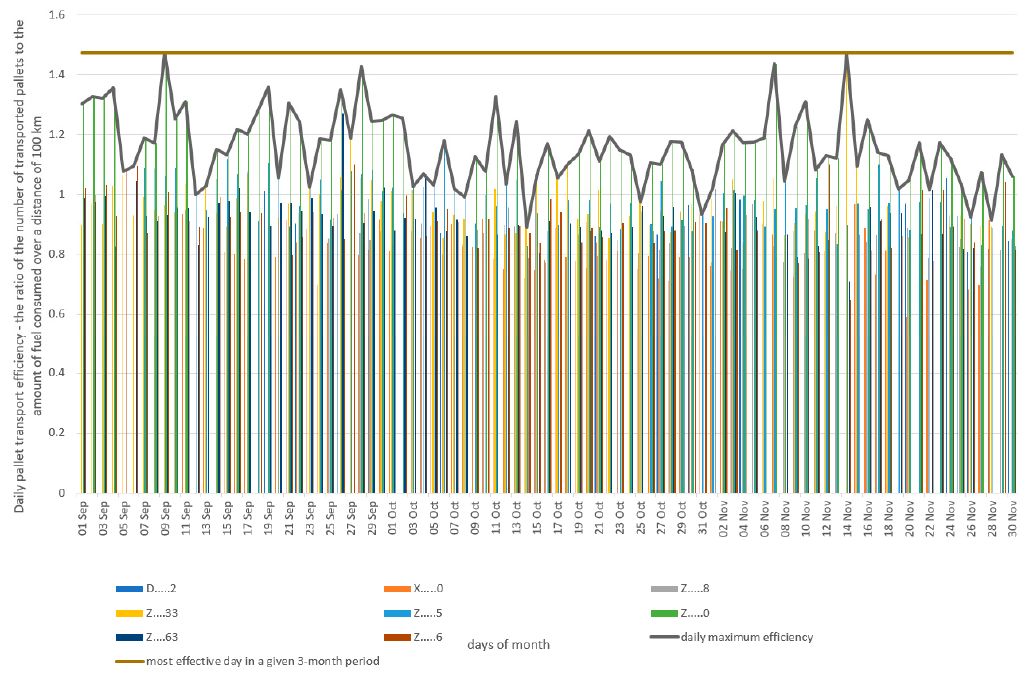
Figure 8. Daily efficiency is the ratio of the number of transported pallets to the amount of fuel consumed over 100 km.